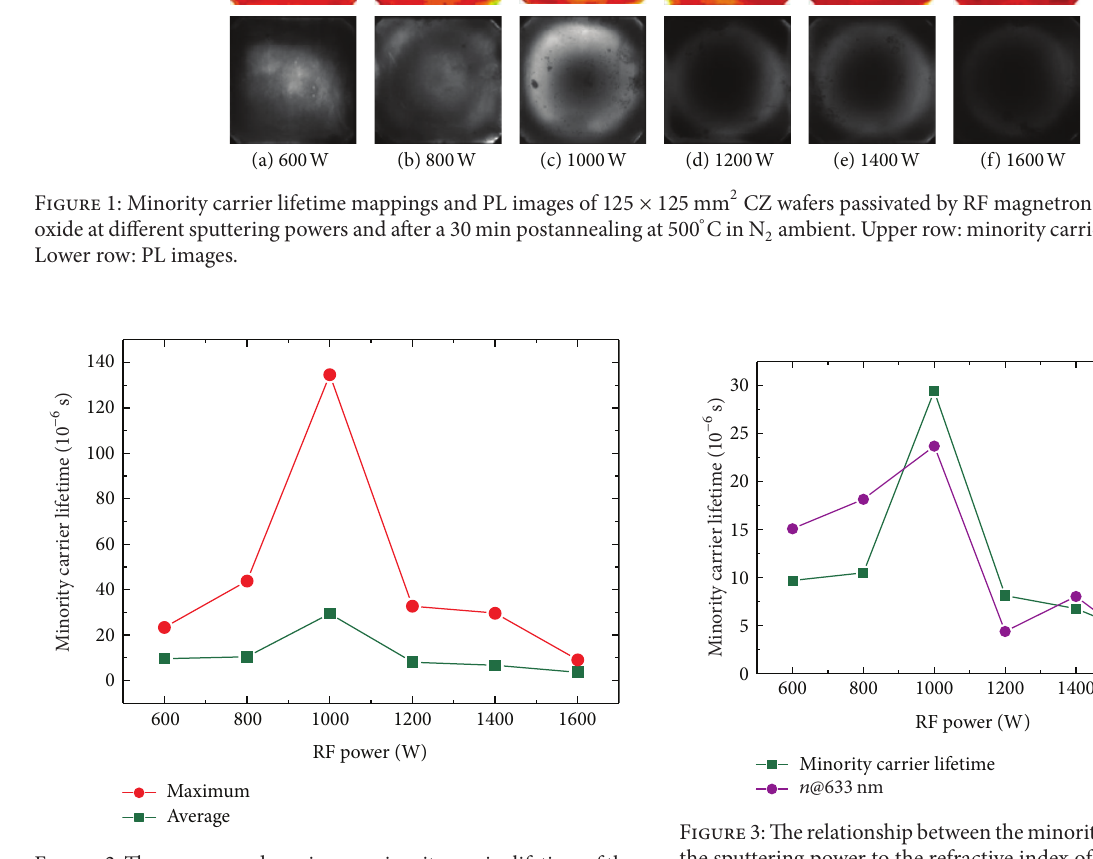
F2:eaverageandmaximumminoritycarrierlifetimeofthe wafers areas as related to the sputtering powers according to Figure